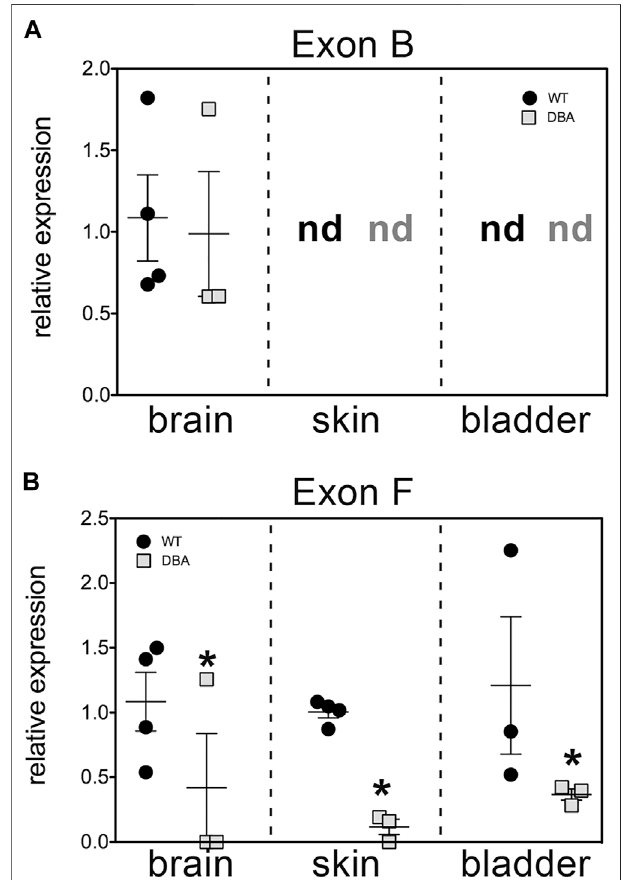
FIGURE4| Relative expression ofvariant exonsinWT and DBAtissues. cDNAs made from total RNA of brain, skin and detrusor of WT animals (black circles, N =4)andDBAanimals(graysquares, N =3)wereassayedintriplicate for Myo5a exon B or for exon F with their speci fi c TaqMan assays, and for 18S rRNA as an internal control. Expression was determined by the ΔΔ Ct method and graphed relative to WT within each tissue. Horizontal line indicates average relative expression ±SEM. (A) Expression of exon B in brain was not different in DBA compared to WT ( p = 0.67). In detrusor and skin, exon Bwasnot detected (nd) and therefore differencesbetween strainscould not be determined. (B) Expression of exon F was lower in DBA brain, skinand detrusor (* p < 0.05) than in corresponding WT